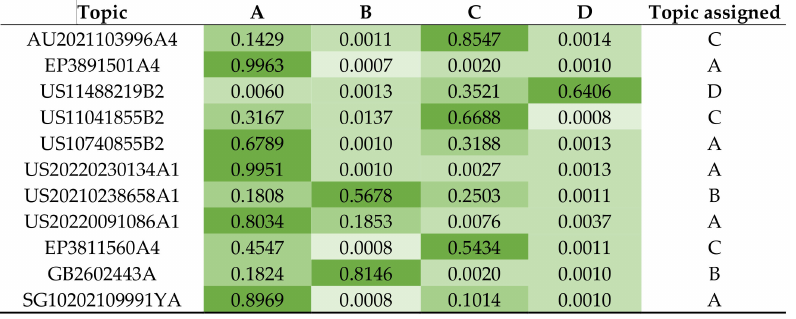
Figure 3. Example of topics heat map resulting from the LDA